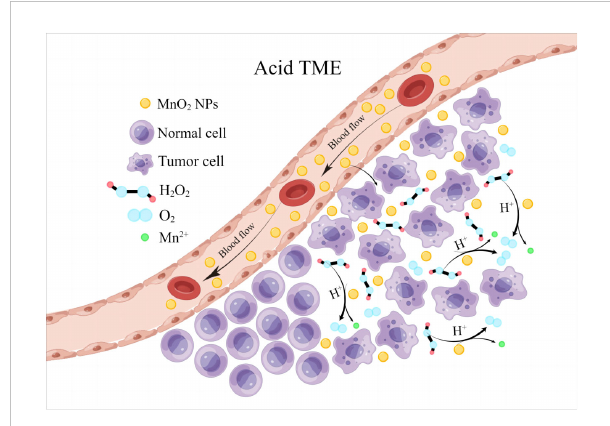
FIGURE 1 MnO 2 NPs remodel tumor microenvironment by reacting with H 2 O 2 to release oxygen and Mn 2+ .